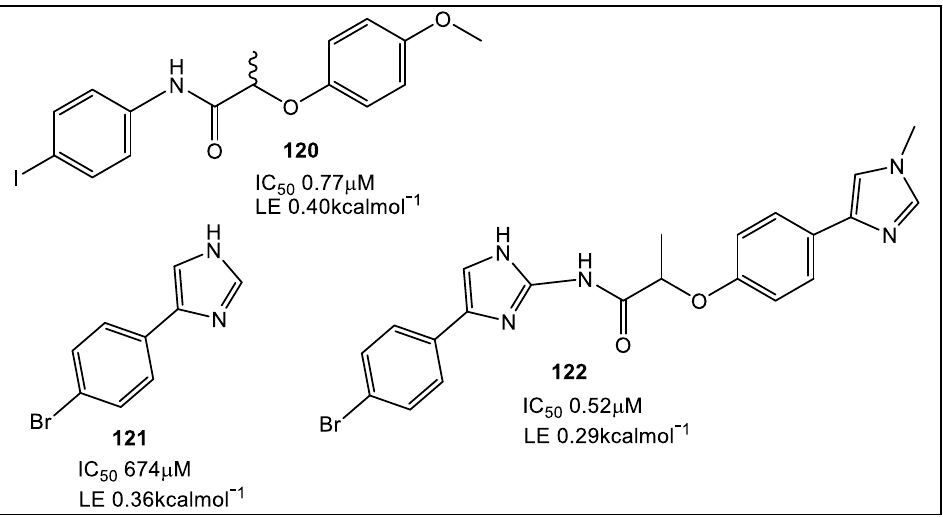
Figure 21. Fragment-linking strategy led to synthesis of 18 compounds based on fragments 120 and 121 . Compound 122 demonstrated markedly improved MthIMPDH ΔCBS inhibition (LE 0.29; 0.52 μM IC 50 ), which compared to 120 and 121 is significantly more potent (1300-fold); compound 121 X-ray structure with shown MthIMPDH at lower right. The racemate 122 has ~50% the Mth IMPDH ∆ CBS inhibition as compared to its ( S )-isomer, a pattern similar to that previously reported for other IMPDH inhibitors [109–111]. However, anti-Mtb H37Rv activity of the most potent analogues (0 –100 μM tested) lacked clinically relevant activity (MIC 90 ≥ 50 μM). This lack of activity may be the result of poor cell permeability, metabolic instability, and/or efflux [109]. Additional information about FBLD developments in the search for anti-Mtb compounds can be found in these recent reviews